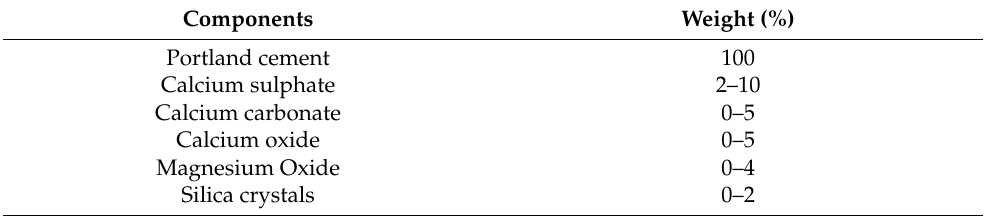
Table 1. Chemical Components